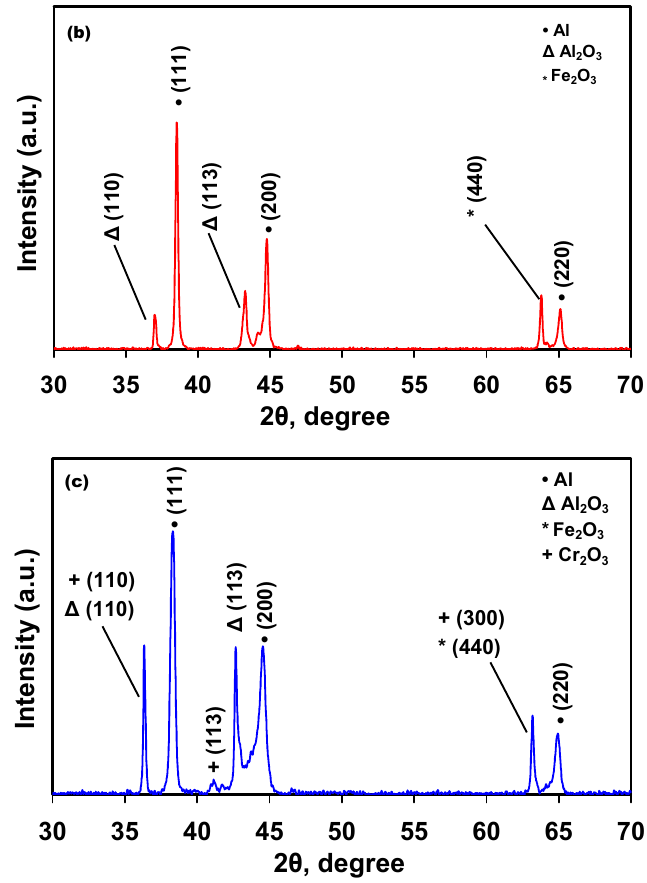
Figure 9. XRD analysis obtained on the nanocrystalline Al ( a ), Al ‐ 10% Fe ( b ) and Al ‐ 10% Fe ‐ 5% Cr ( c ) alloy after corrosion.